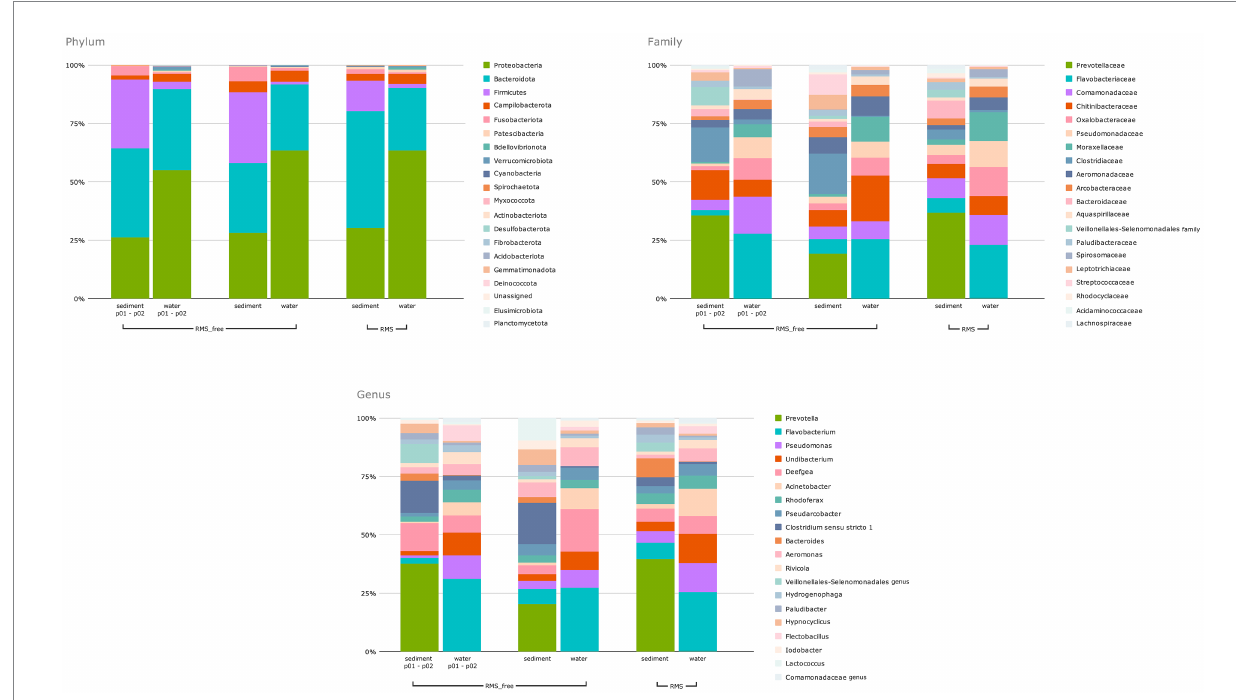
FIGURE 3 Bar chart regarding the distribution of the 20 most abundant Phyla, Families, and Genera.